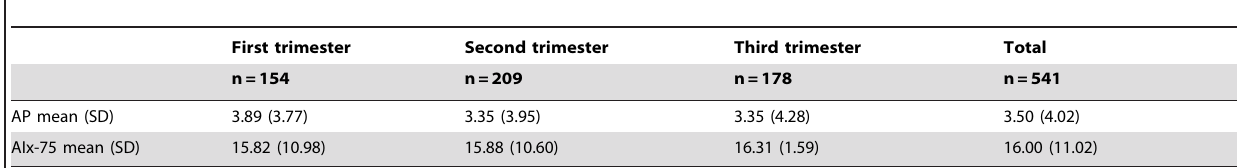
Table 2. Mean and standard deviation (SD) of augmentation pressure (AP) and augmentation at heart rate 75 beats per minute (AIx-75) in each